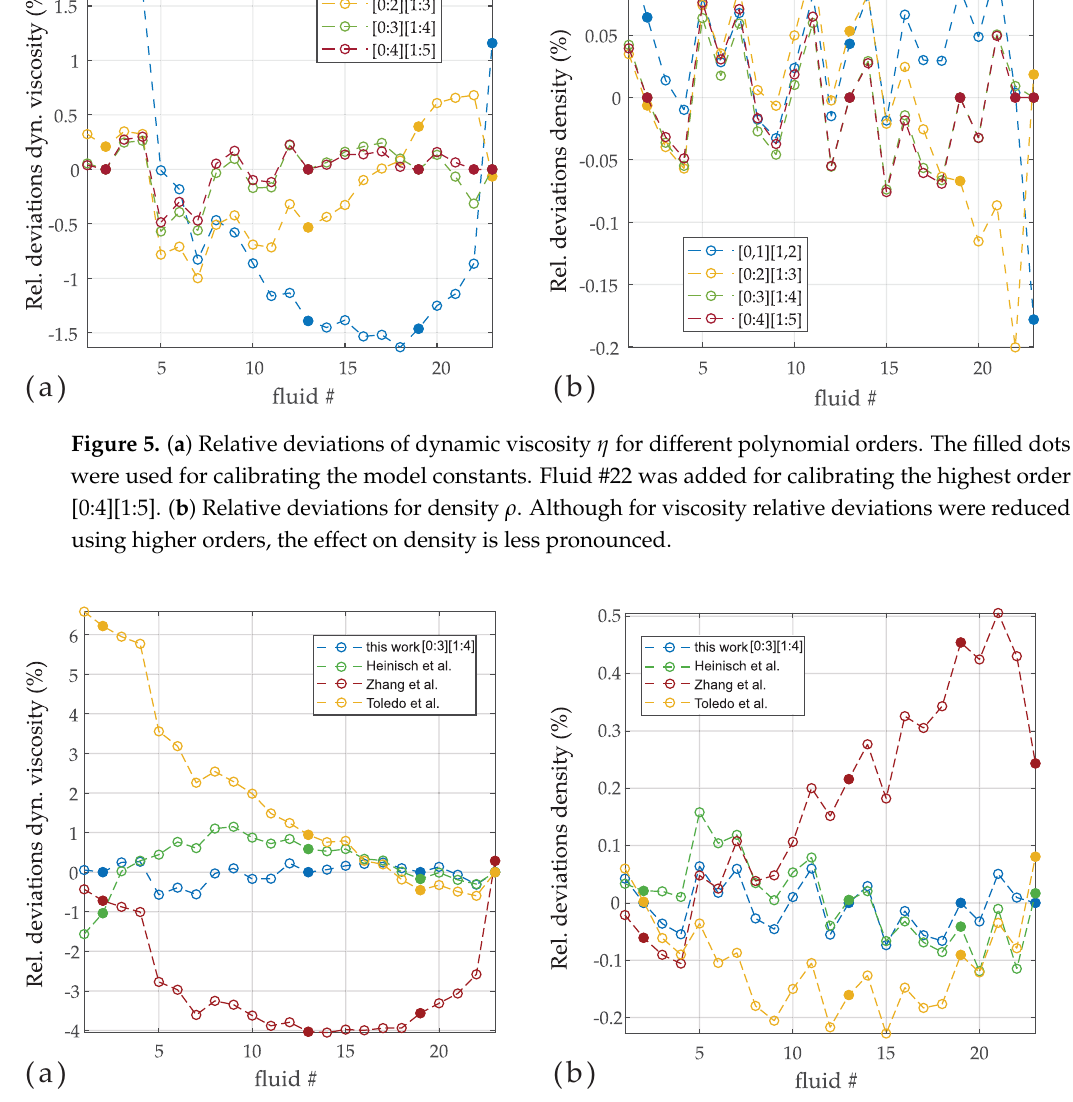
Figure 6. ( a ) Relative deviations of dynamic viscosity η for different models. The filled dots were used for calibrating the model constants. ( b ) Relative deviations for density ρ